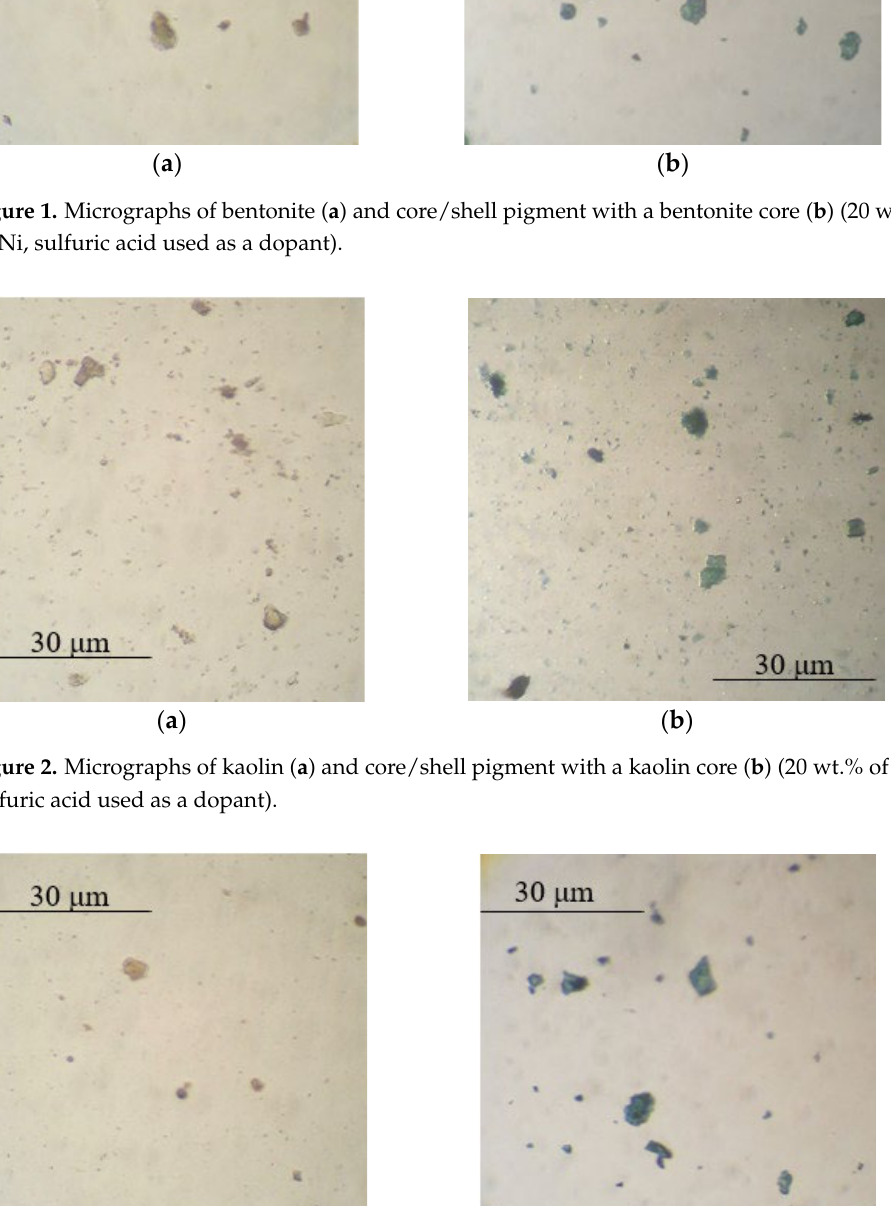
Figure 4. Micrographs of the mechanical mixture of H 2 SO 4 -doped PANi (20 wt.%) and talc (80 wt.%). The pictures obtained using scanning electron microscopy, also, confirm the for- mation of core/shell pigments (Figure 5).